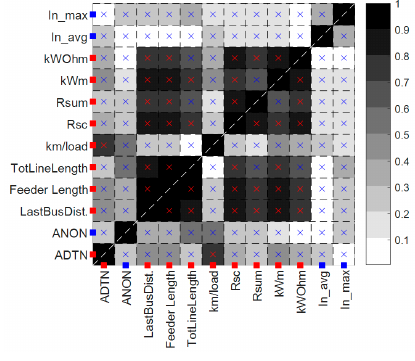
Figure 3. Correlation map (Spearman correlation). Red and blue crosses show a correlation higher or lower than the threshold of 0.70.